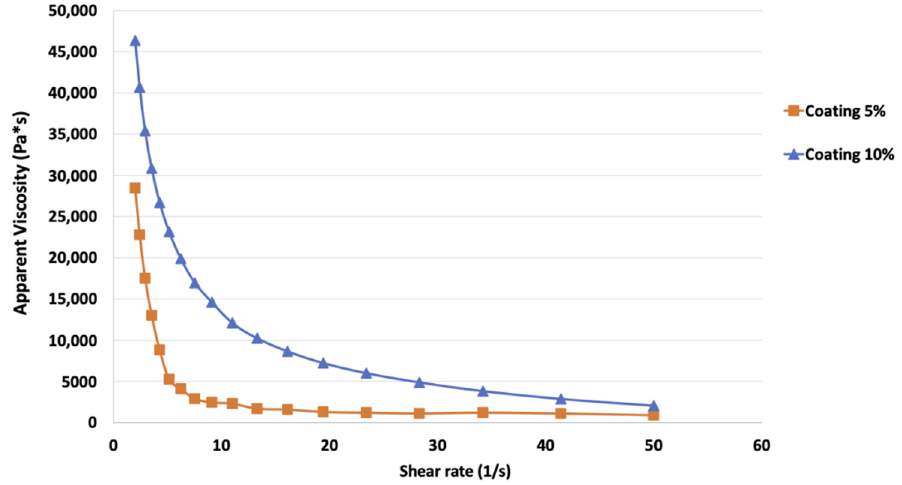
Figure 1. Flow curves of the alginate coating solution at 5% and 10% concentrations ( w/w distilled water), obtained increasing the shear rate from 2 to 50 s − 1 .